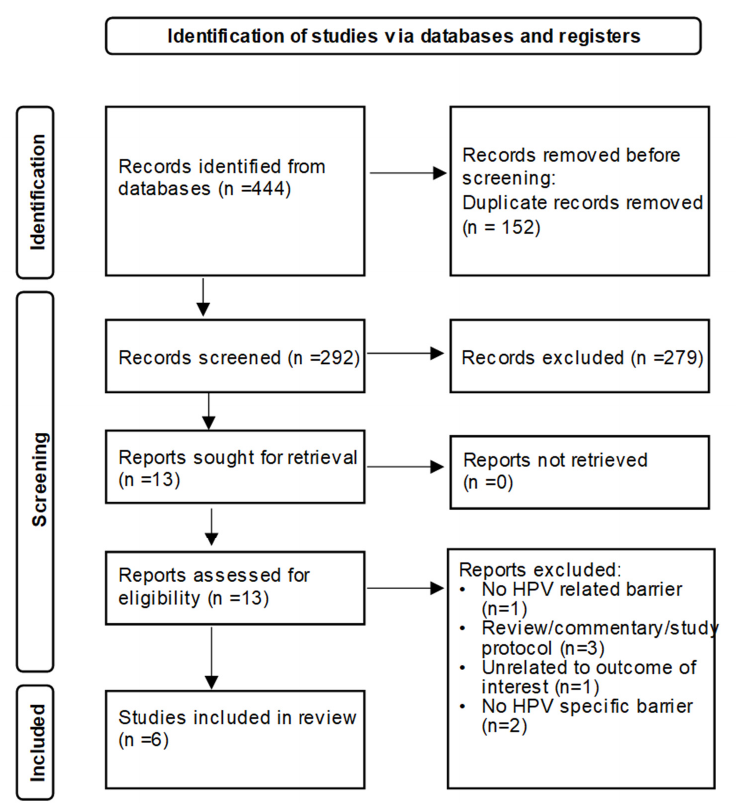
Figure 1. PRISMA diagram showing search and selection. Table 1. Characteristics of included studies.